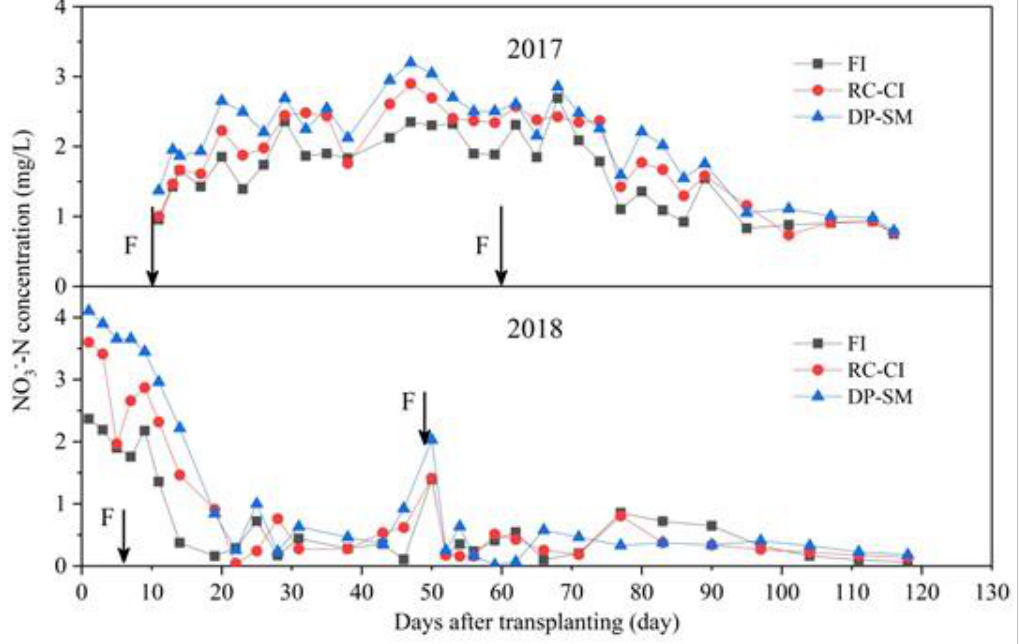
Figure 8. NO 3 − -N concentrations in percolation water under di ff erent irrigation regimes (The arrows indicate Figure 8. NO 3− -N concentrations in percolation water under different irrigation regimes (The arrows indicate fertilization).